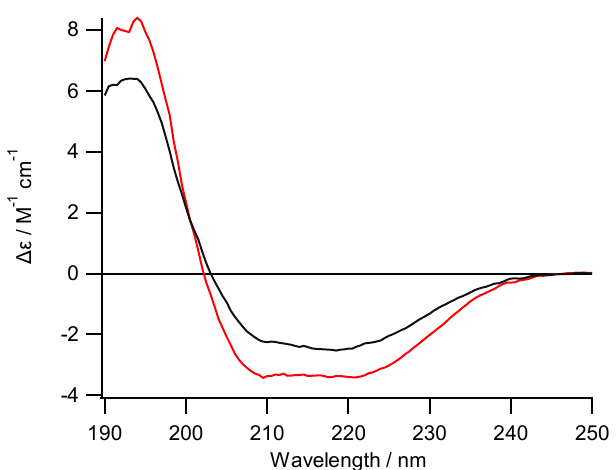
Figure 2. Circular dichroism spectroscopy of folded ZZlinkZZctOmpA (red trace) at 0.20 mg mL −1